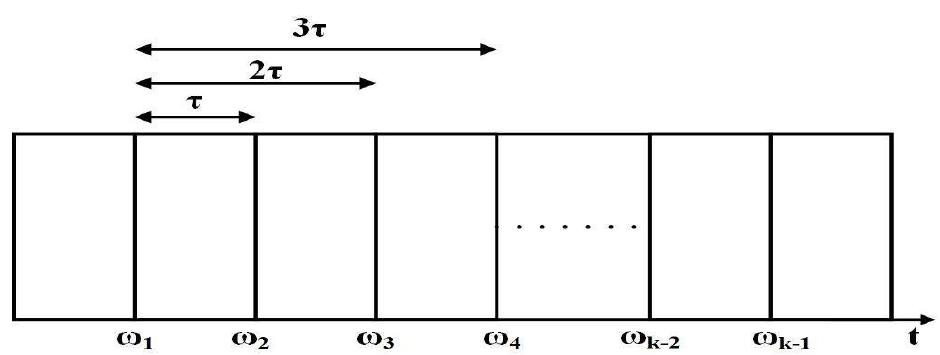
Figure 5. Sliding windows to calculate PER.